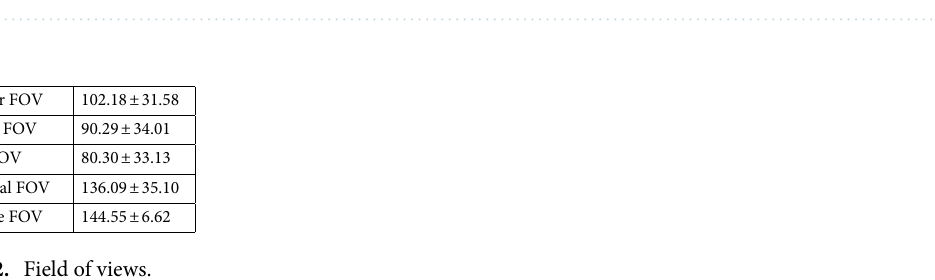
Table 1. Demographics.